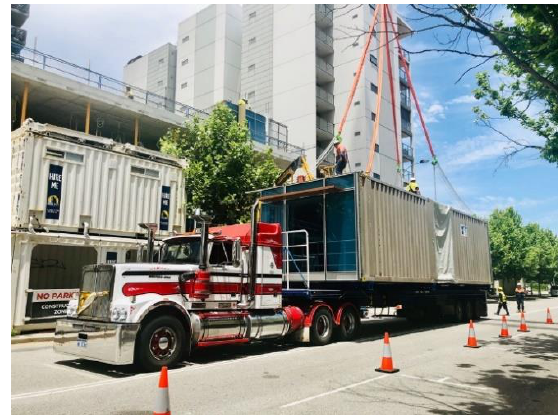
Figure 4. Module transport to construction site (photo by Y. Sun).